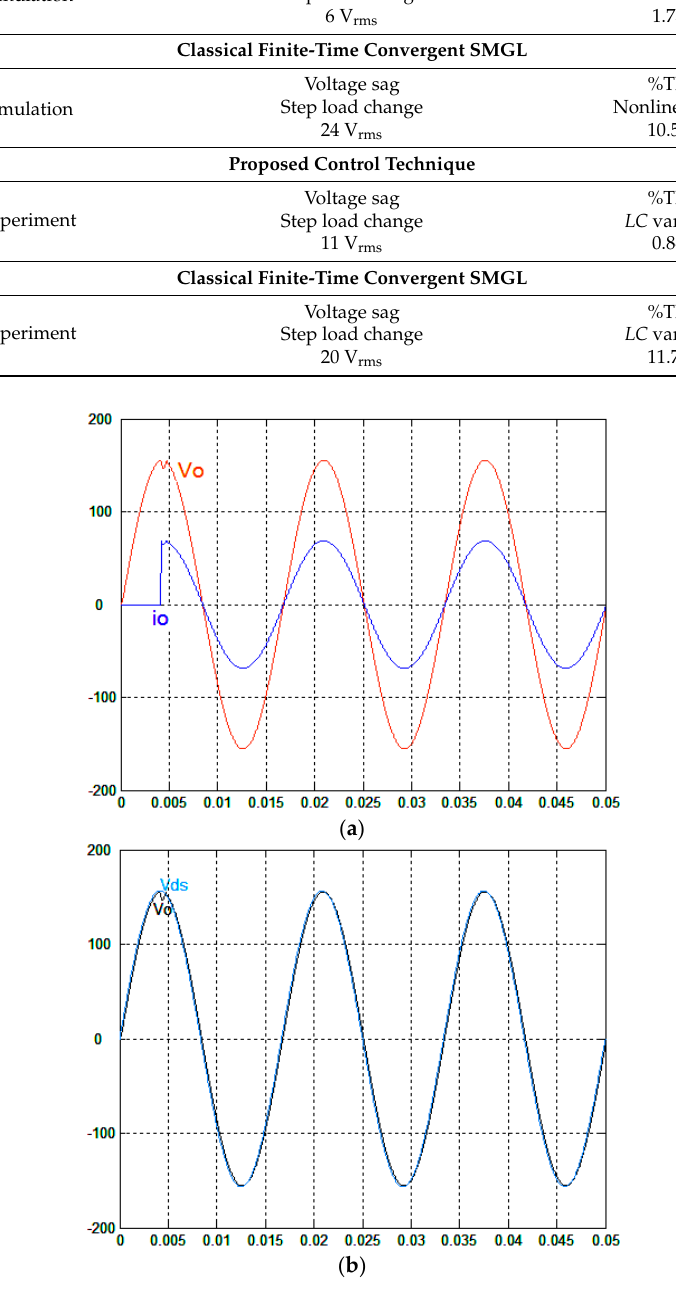
Figure 2. ( a ) Simulation waveforms of the output voltage and output current under step load change for the proposed control technique (100 V/div; 20 A/div); ( b ) Trajectories of output voltage and reference sine wave.